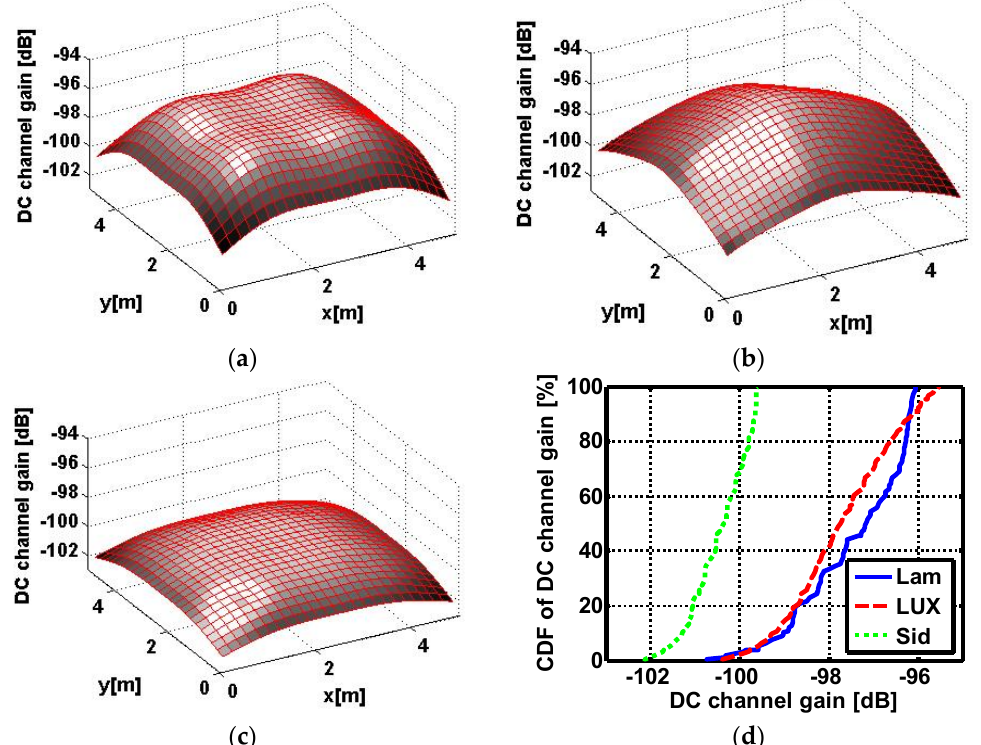
Figure 4. DC channel gains spatial distribution of ( a ) Lambertian optical beam case; ( b ) LUXEON Rebel optical beam case; and ( c ) Side Emitter optical beam case. ( d ) Cumulative distribution function of the above DC channel gains.